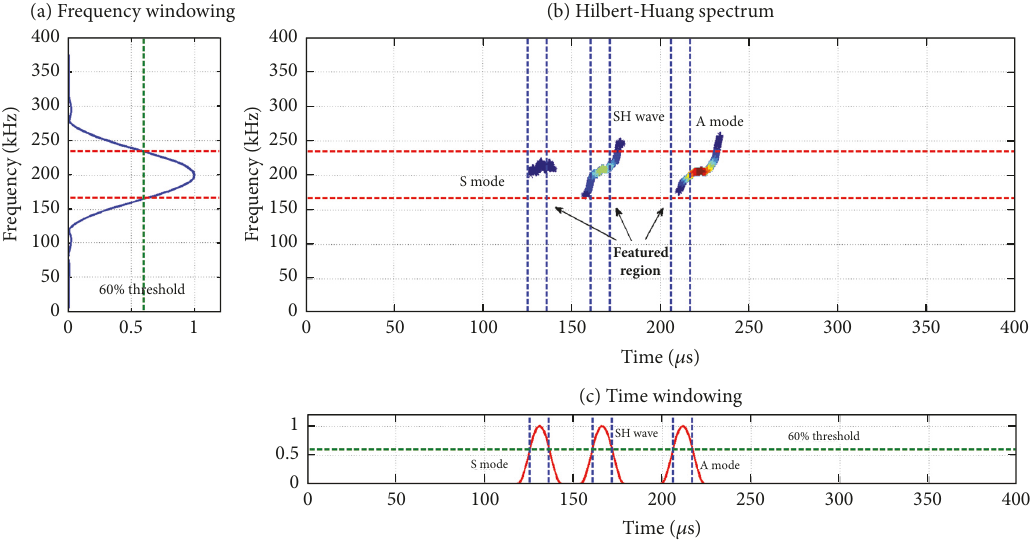
Figure 6: Formation of damage